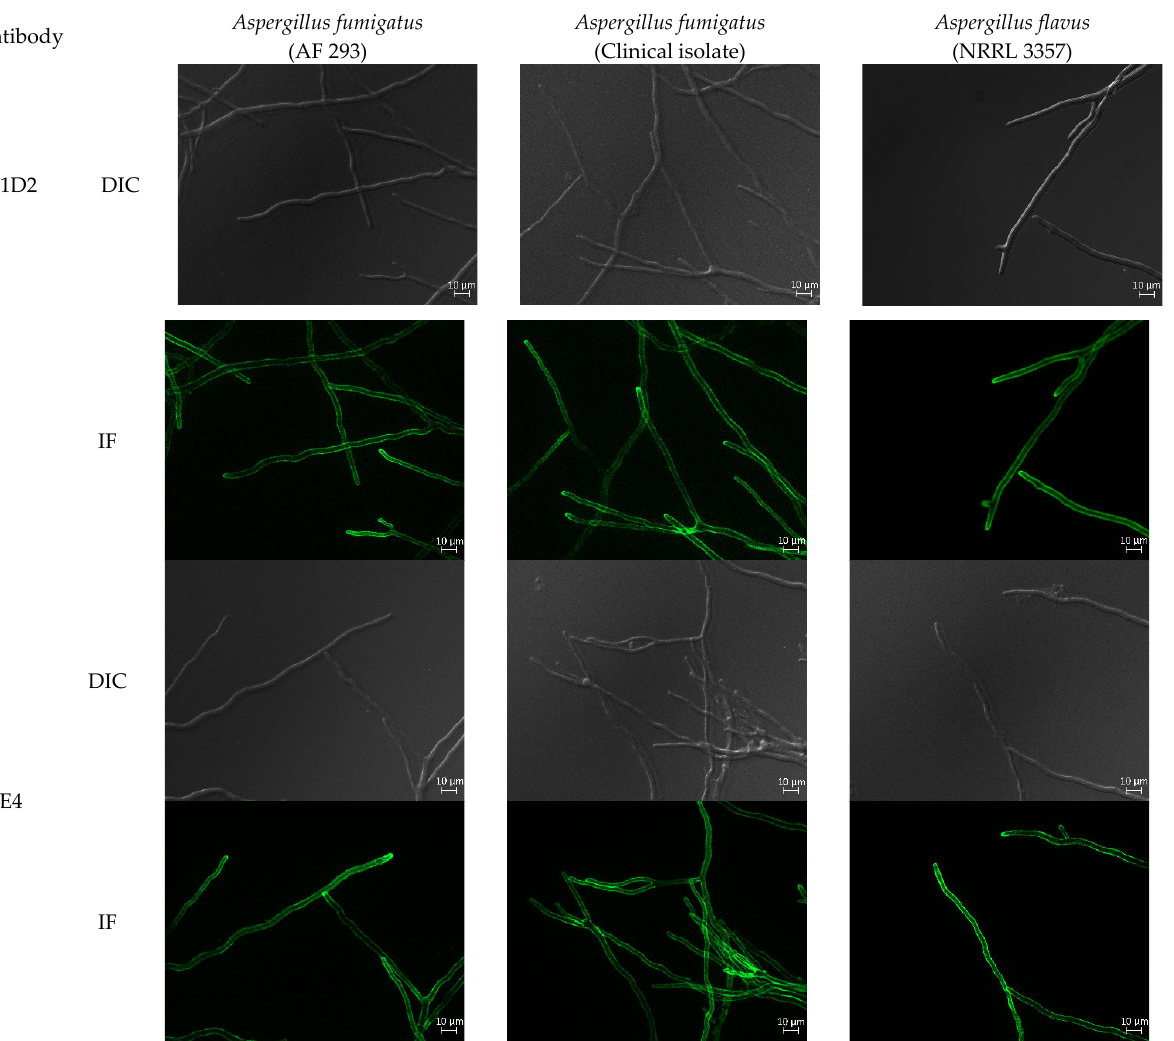
Figure 2. mAbs 1D2 and 4E4 stain Aspergillus fumigatus and Aspergillus flavus. 1D2 and 4E4 identified the cell wall antigens of A. fumigatus including ATCC strain and clinical strains, and A. flavus . All of them showed intense fluorescence, particularly on the hyphal tips. DIC: differential interference contrast | IF: immunofluorescence.